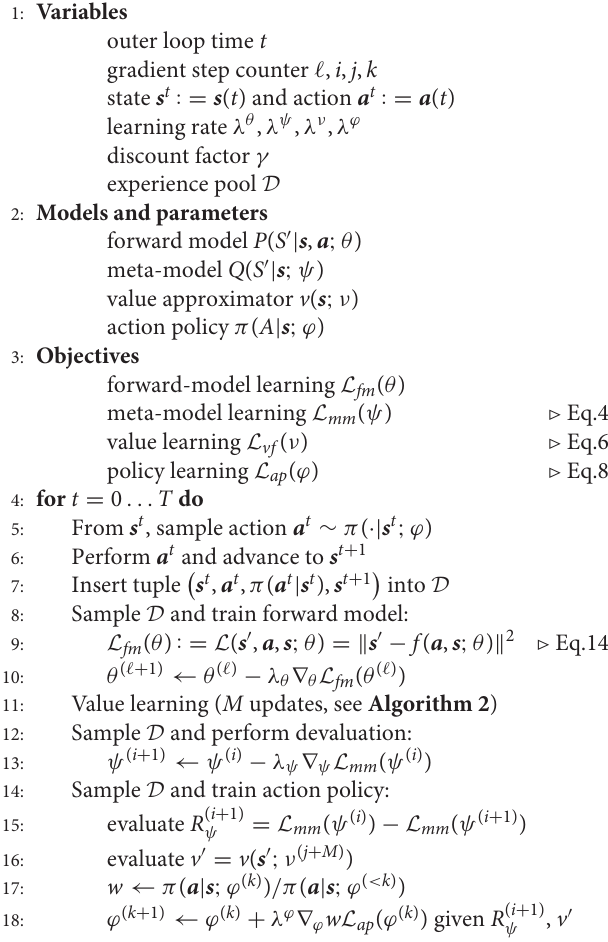
Algorithm 1 Homeo-heterostatic value gradients